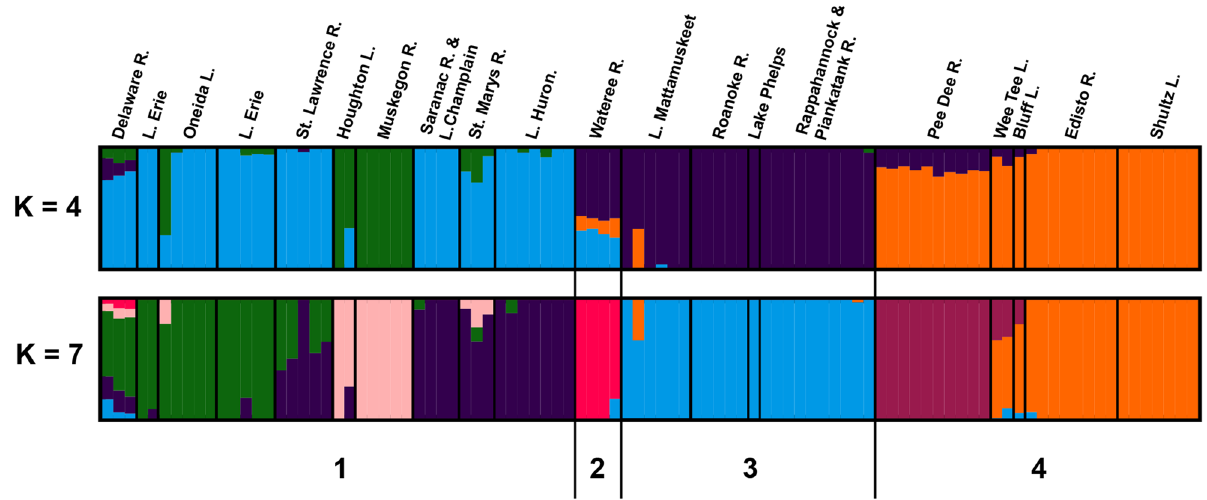
Figure 3. Results of admixture analysis for K = 4 (CV error = 0.25) and K = 7 (CV error = 0.27). Samples are ordered according to the tree in Fig. 2a and labels at the bottom correspond to population clustering as determined using